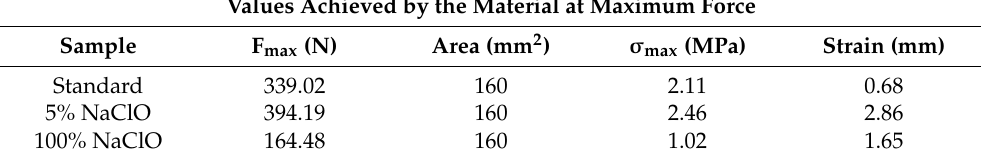
Table 9. Values achieved by oak at maximum force during tensile testing of the standard sample and samples immersed for three months in 5% and 100%